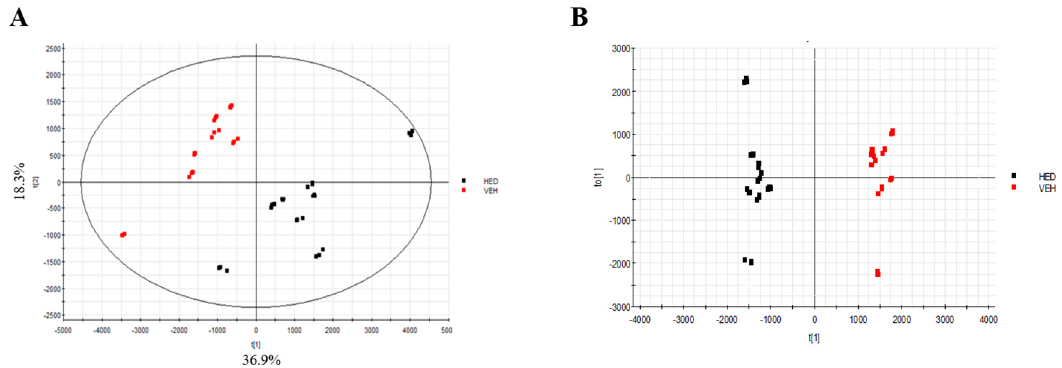
Figure 3. Score plots of the serum samples from the vehicle and HED groups. ( A ) principal component analysis (PCA) score plot and ( B ) orthogonal projections to latent structures discriminant analysis (OPLS-DA) score plot. Vehicle, SD rat fed chow diet; HED, SD rat fed HED.